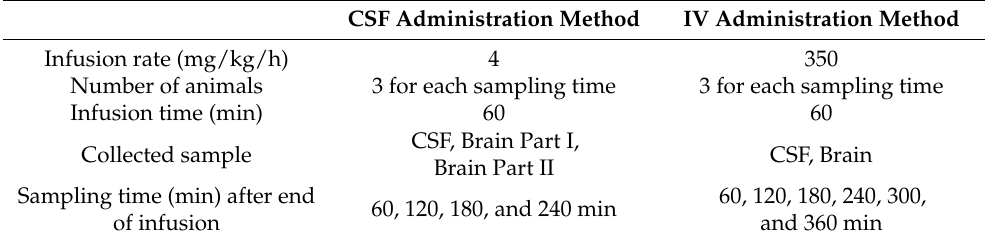
Table 1. Experimental conditions of BPA uptake into brain cells administered in normal rats using either the boron CSF administration method or IV administration method.